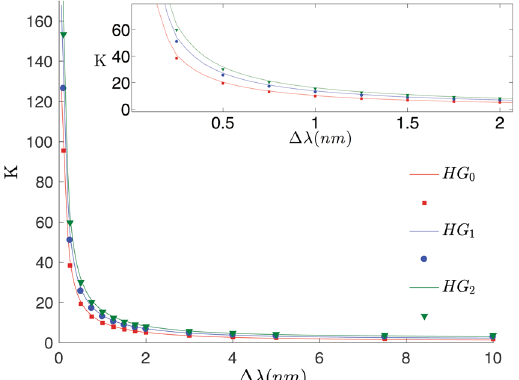
Figure 3. Spectral cooperativity K , estimated from the reduced model, Eq. (5), and from an exact calculation. We report the three cases of Hermite-Gauss spectra of order 0, 1, and 2, with spectral bandwidths Δ λ . The approximation holds to a satisfactory level, as shown in the inset which reports a close up of the whole curve. Notice how the number of modes generated increases with the order.